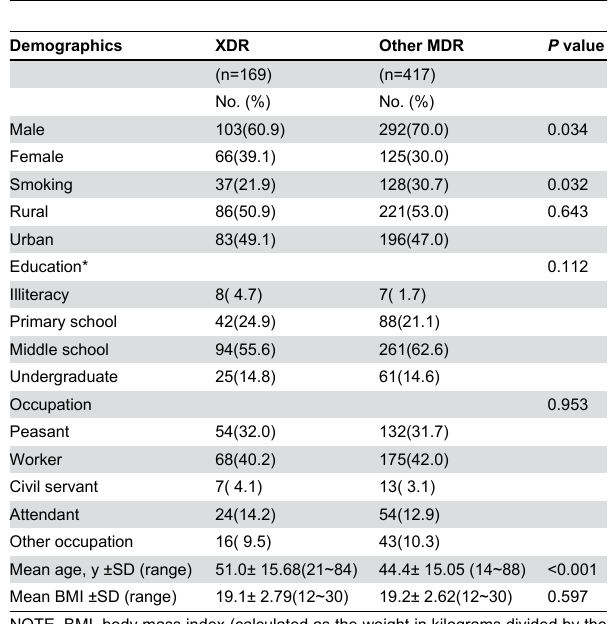
Table 1. Demographics of patients with XDR-TB and Other